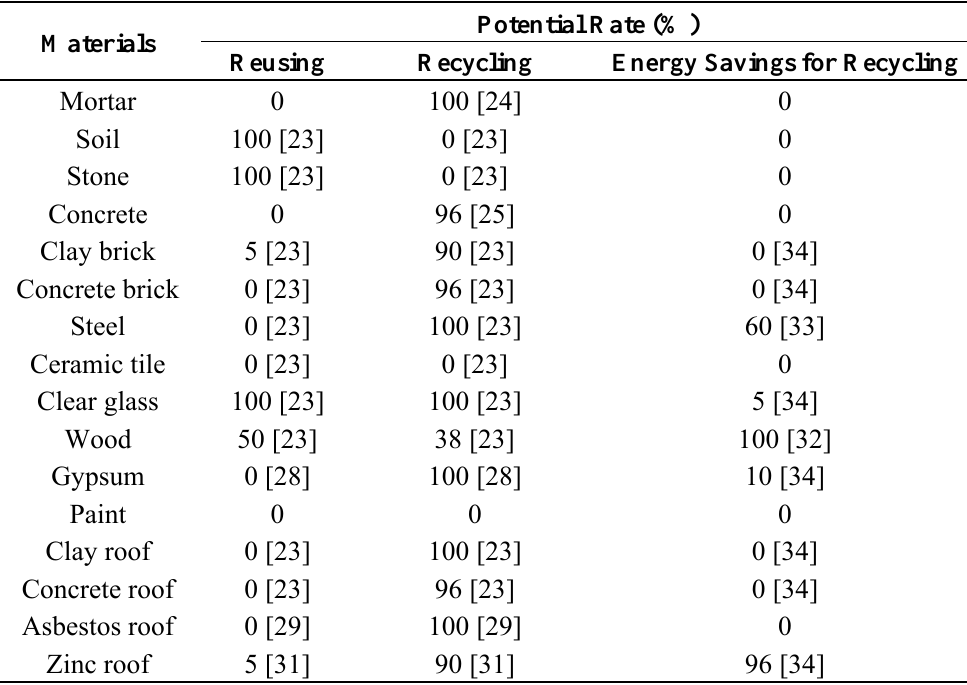
Table 2. Potential reusing and recycling